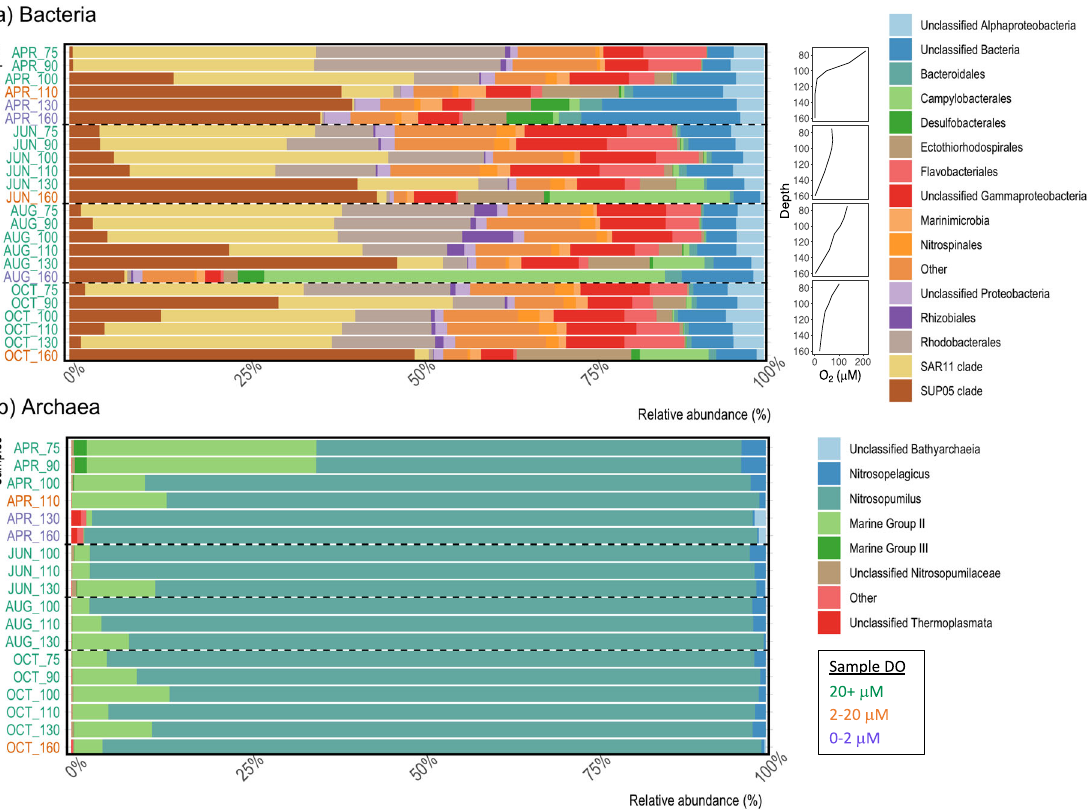
Fig. 1 Bacterial and archaeal community structure. Compositional barplots showing relative abundances of a Bacteria and b Archaea ASVs in Saanich inlet seston samples. Dissolved oxygen pro fi les for each sampling period are reported in panel ( a ). Samples were obtained from Saanich inlet between April and October 2018. Sample labels on the vertical axes correspond to sampling month and water column depth. Vertical axis labels are color coded according to in situ dissolved oxygen